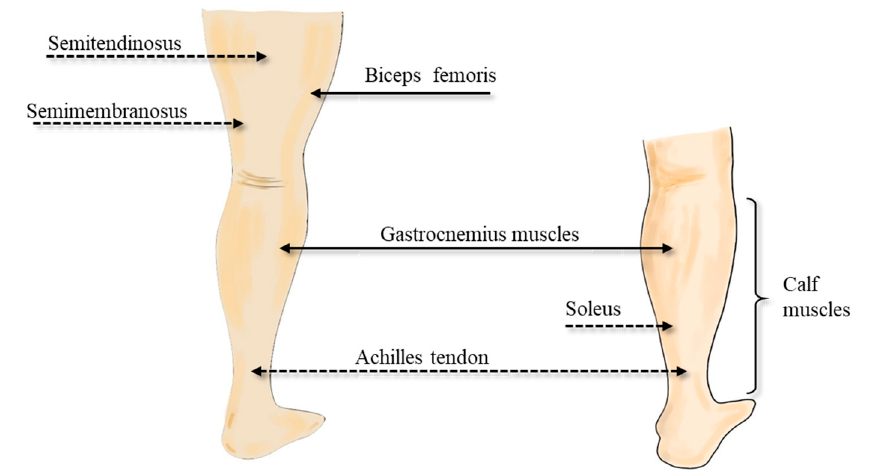
Figure 3. Real-time measurement location for EMG bio-signal (Left image: biceps femoris, right image: gastrocnemius muscle).